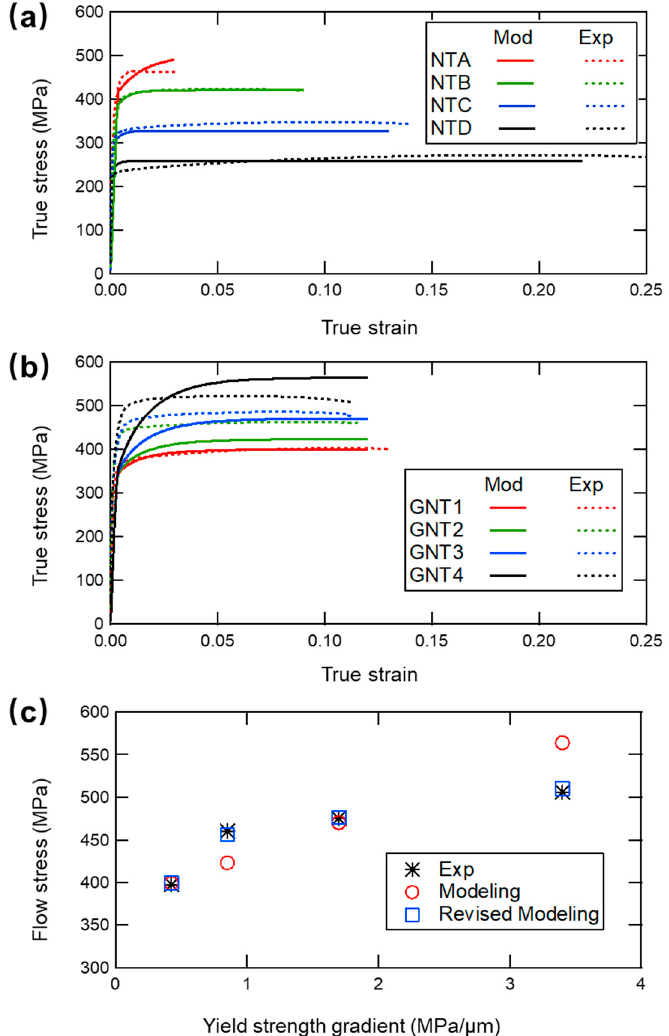
Figure 2. Mechanical properties of samples from modeling results and previous experiment. ( a ) True stress-true strain curves of NT samples. ( b ) True stress-true strain curves of GNT samples. ( c )Flow stress obtained from experimental, modeling and revised modeling results with various yield strength gradient. Experimental data come from Ref. [5].